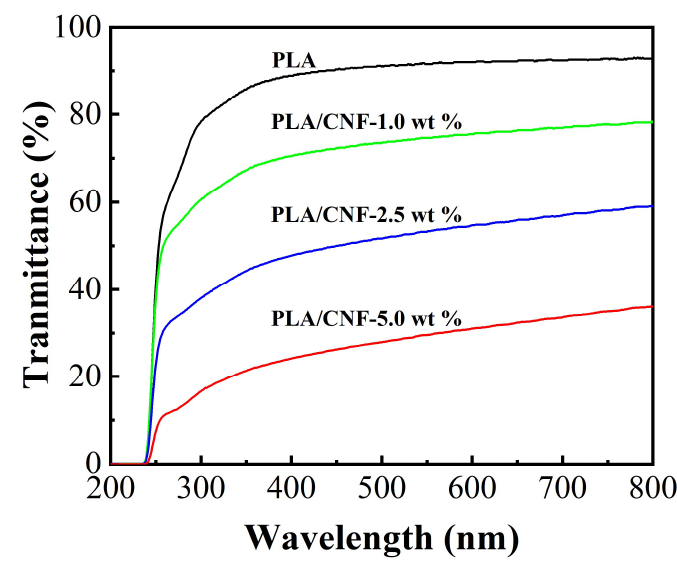
Figure 4. Optical transmittance of PLA/CNF biocomposite films with different CNF loading: neat PLA (black); PLA/CNF-1.0 wt % (green); PLA/CNF-2.5 wt % (blue); and PLA/CNF-5.0 wt % (red).